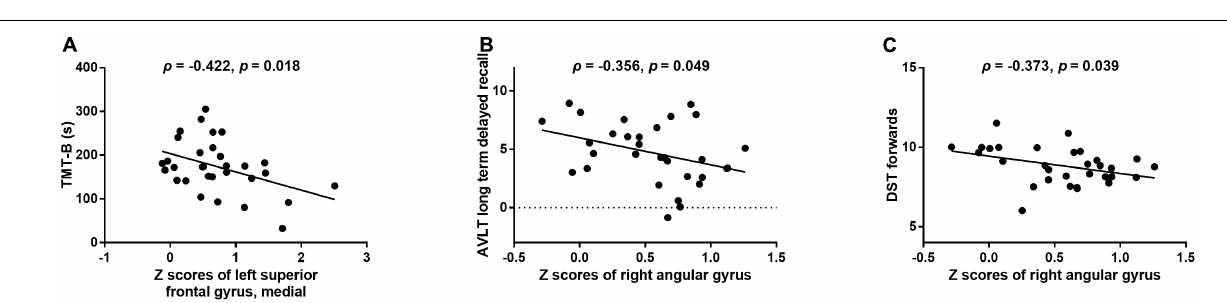
FIGURE 4 | The relationships between changed FCD and aberrant neuropsychological tests in the T2DM group. (A) Z scores of FCD in the medial part of the left superior frontal gyrus vs. scores of the TMT-B test. (B) Z scores of FCD in the right angular gyrus vs. scores of the AVLT long-term delayed recall. (C) Z scores of FCD in the right angular gyrus vs. scores of the DST